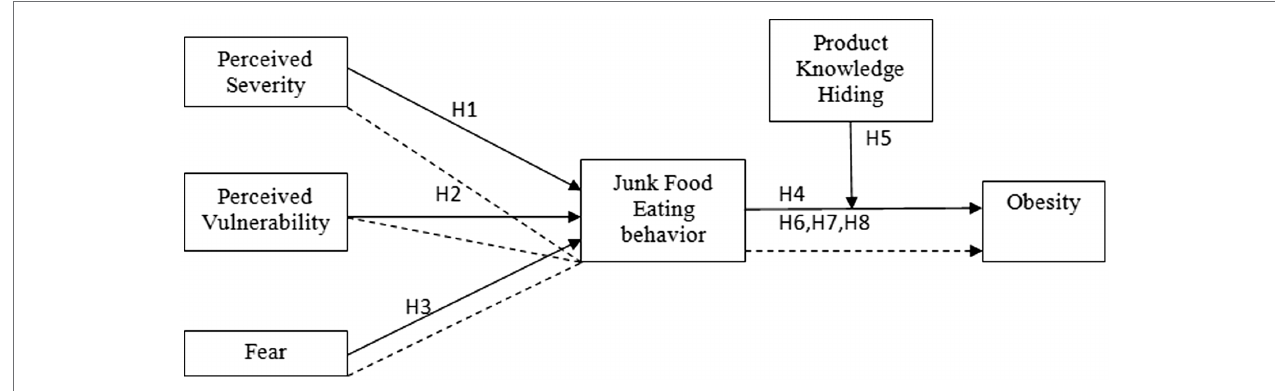
FIGURE 1 | Conceptual